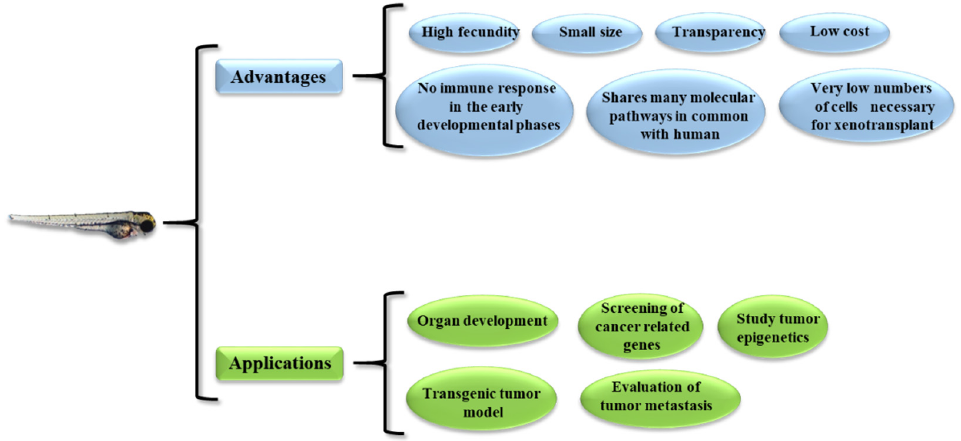
Figure 1. Advantages and possible application of the zebrafish model .